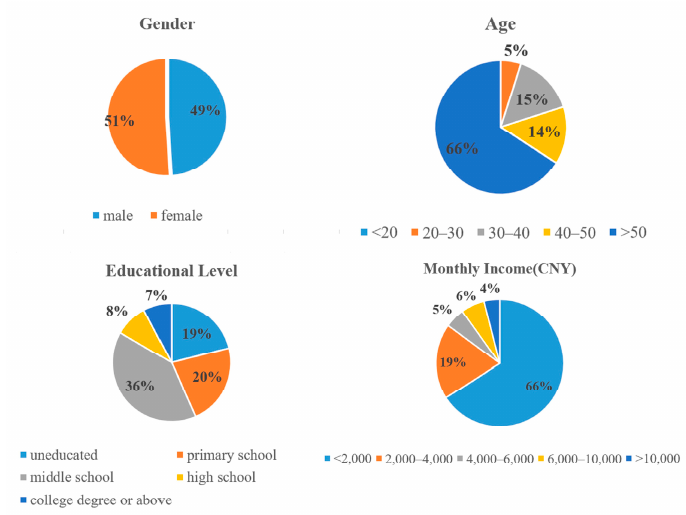
Figure 10. The descriptive statistics of samples from Tianquan Community.